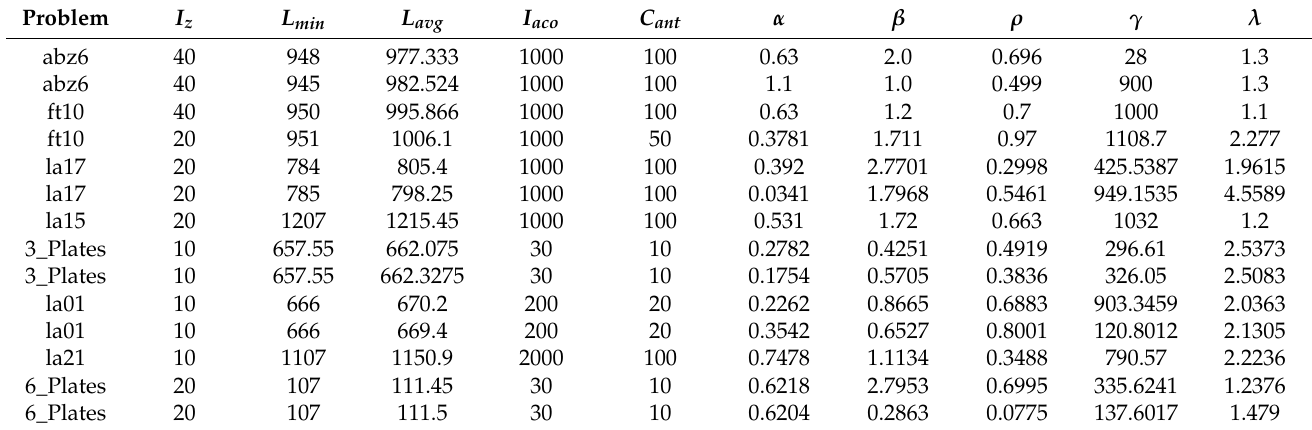
Table 1. Examples of the best sets of coefficients obtained using the genetic